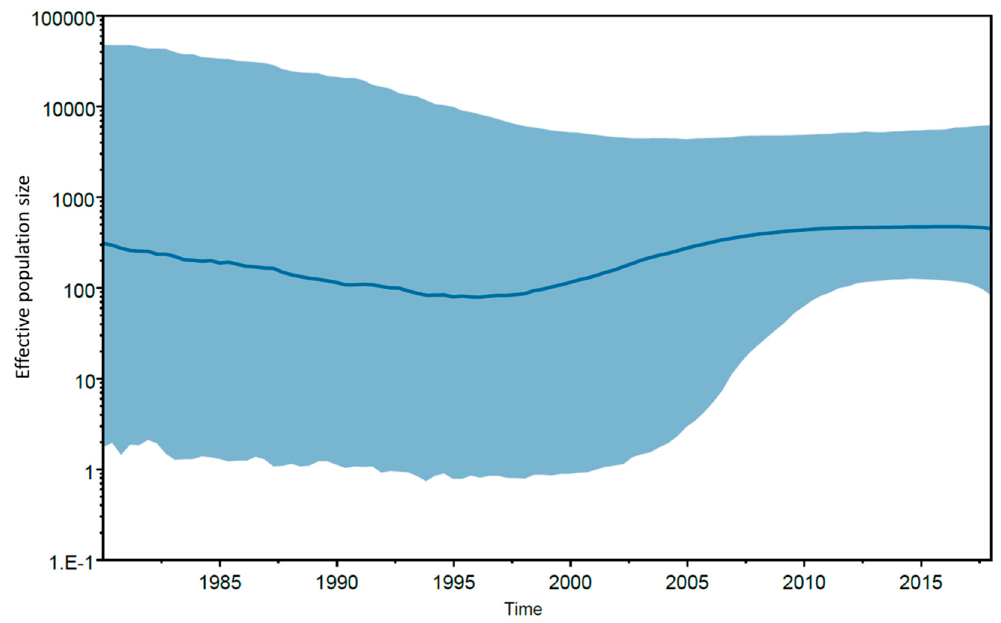
Figure 5. Bayesian skyline plot showing the epidemic history of Brazilian HCV-2b. Median (solid line) and upper and lower 95% HPD (solid area) estimates of the effective population size ( Y -axis; log 10 scale) through time ( X -axis; calendar years) are presented in the graph.